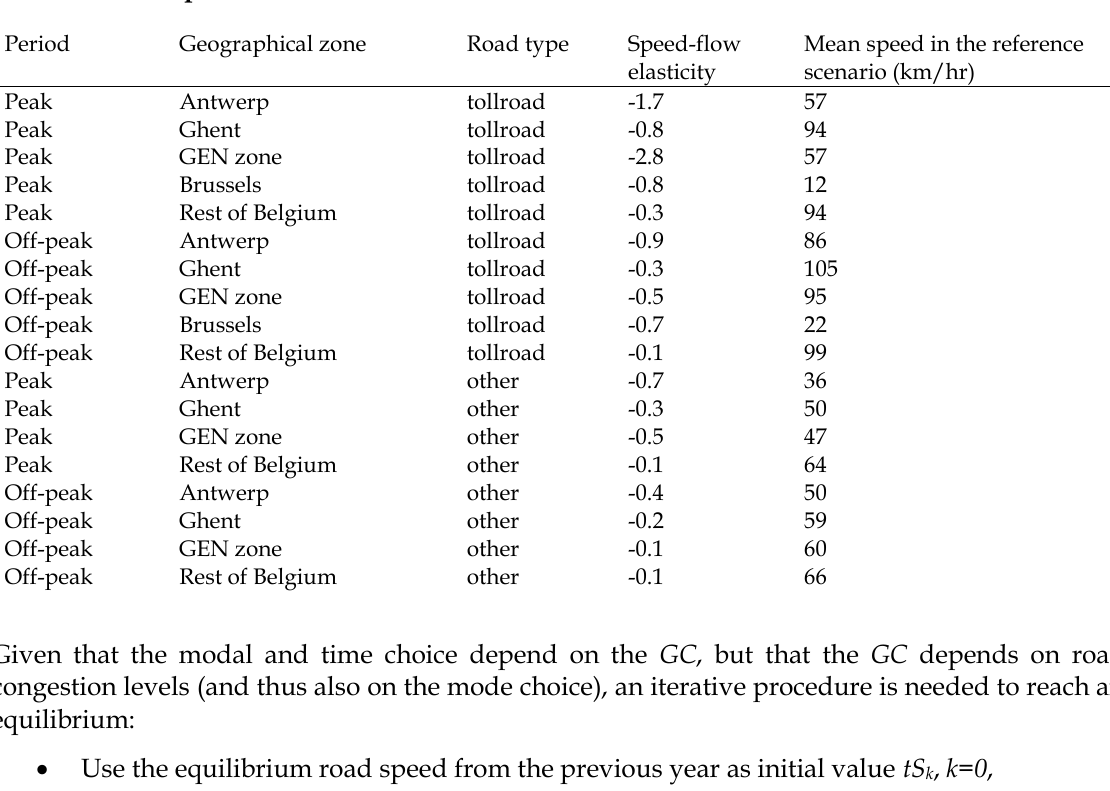
Speed flow elasticities used in